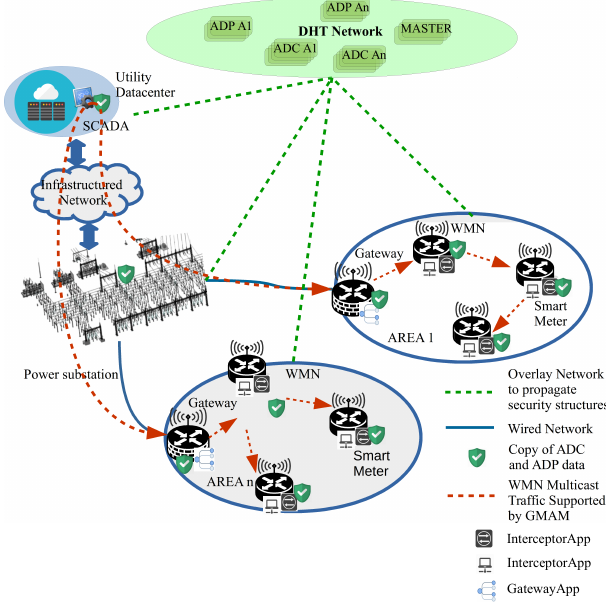
Figure 4. Group subscription information propagated by